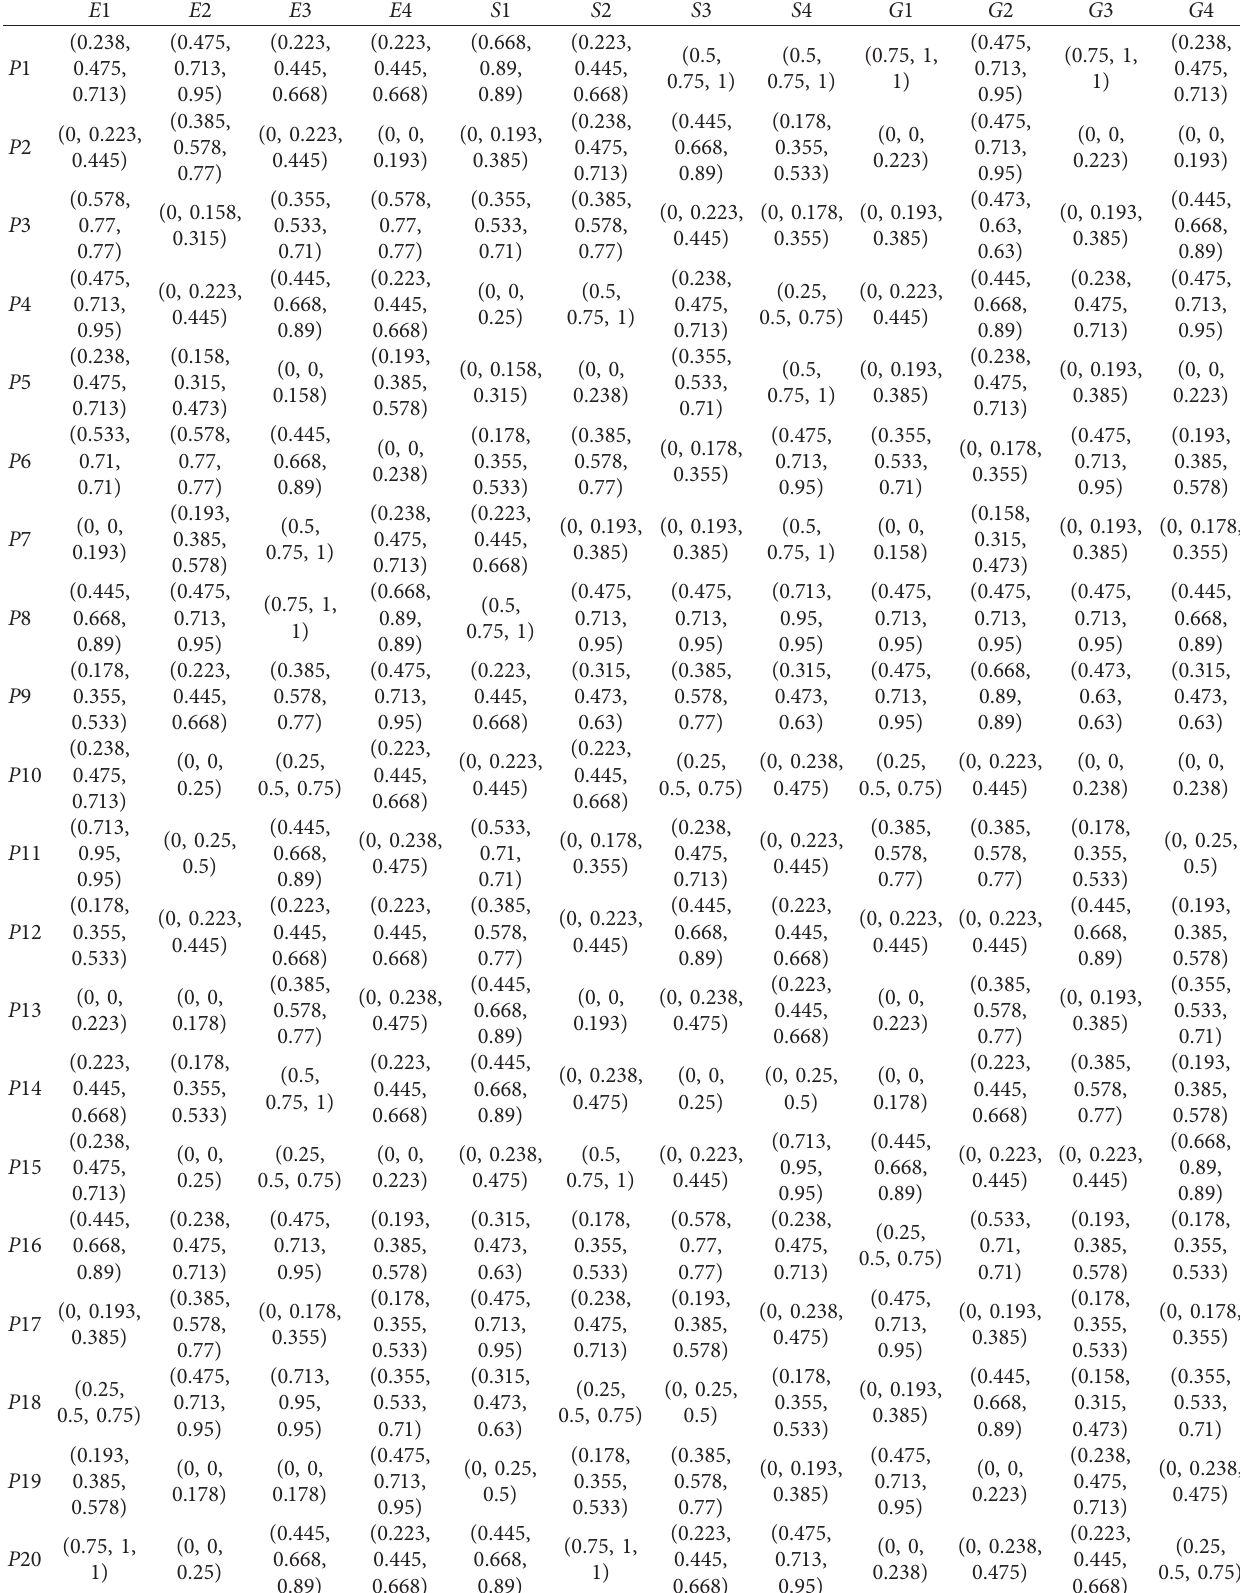
Table 14: Quantified probabilistic linguistic scoring variable for sustainability criteria for proposed